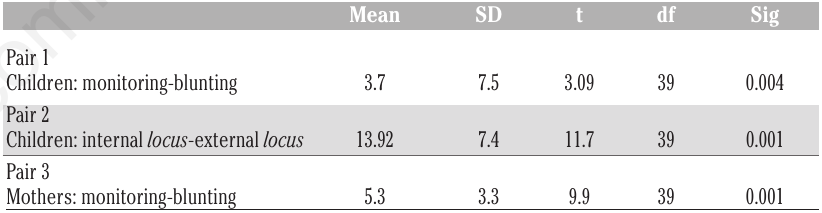
Table 3. Paired samples test (experimental group’s children and their mothers).